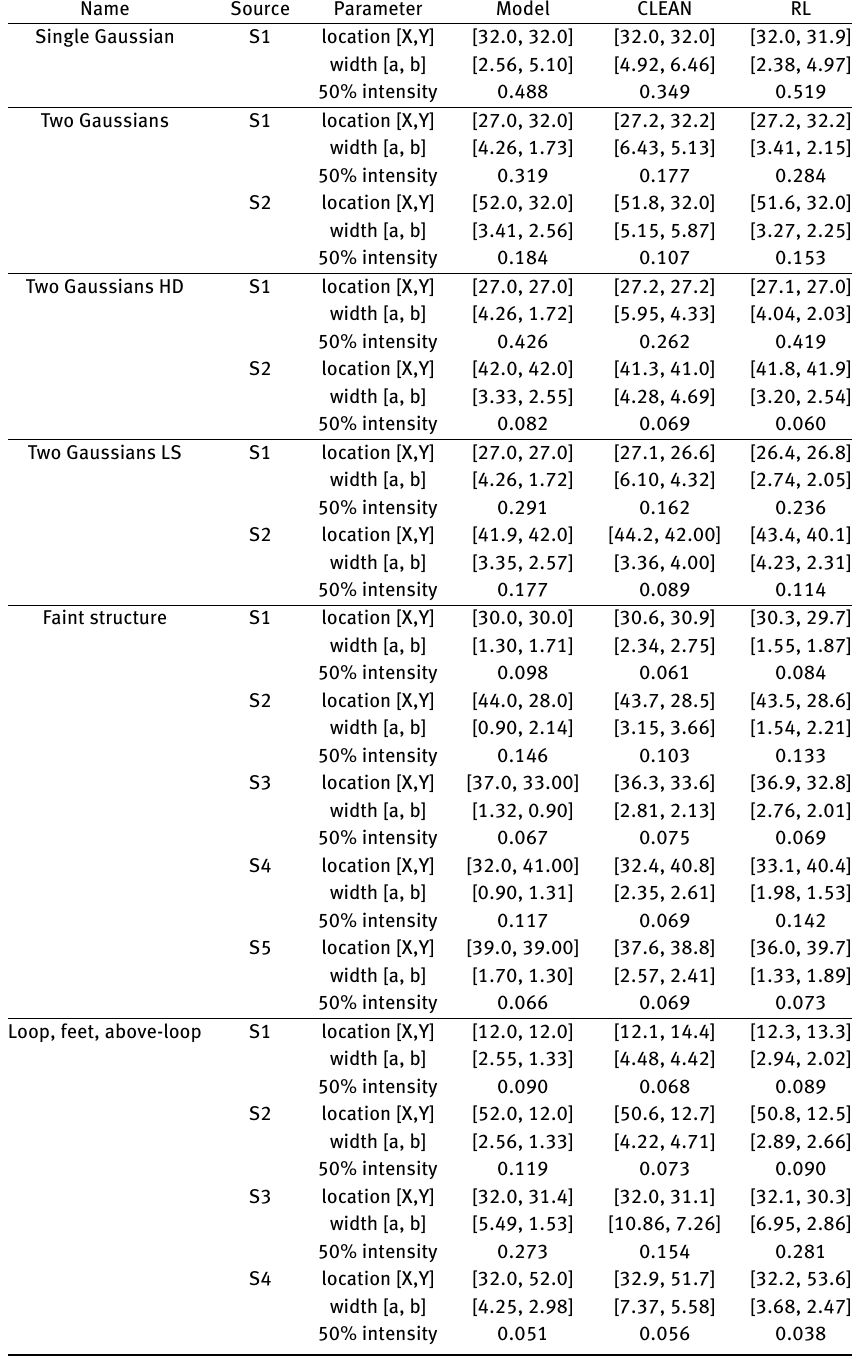
Table 1. Details of test results for each sources configuration presented in Figure